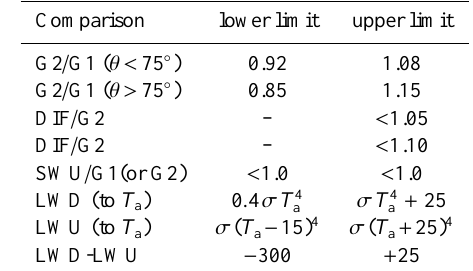
Table 4. Across quantity as defined in the BSRN guidelines. G2 is the SWD measured by the pyranometer. G1 is the SWD obtained as sum of di ff use and direct components. S a = 1368W / m 2 is the solar constant that should be scaled according to the earth-sun distance, while µ is the cosine of the solar zenith angle θ . Values involving LWD are expressed in W / m 2 , the others are dimensionless.